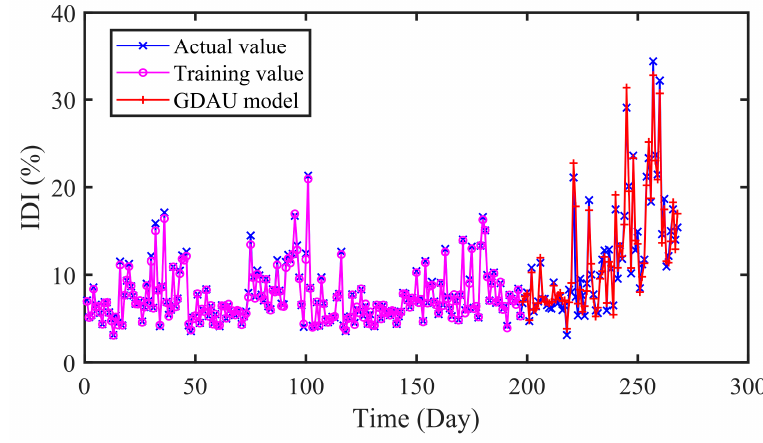
Figure 14. The predicted results of LSTM model .